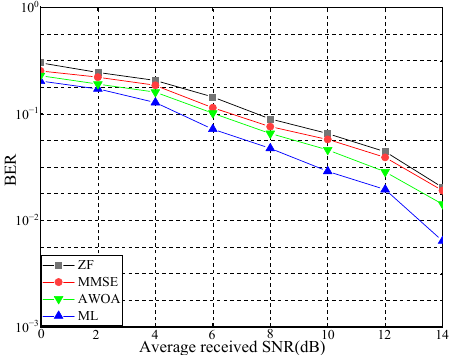
Figure 10. BER in 2*4 MI-MIMO. Figure 10. BER in 2 × 4 MI-MIMO.